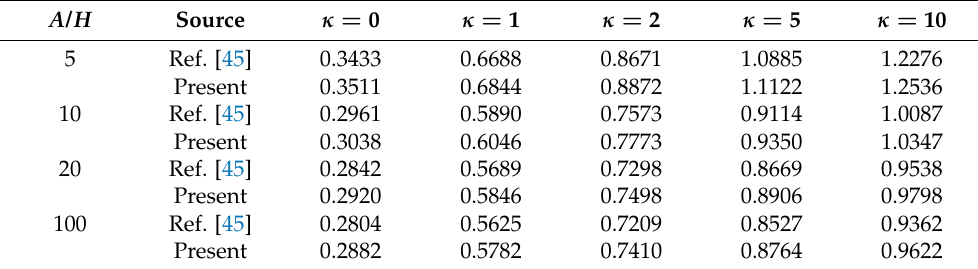
Table 3. Comparison of the central deflection ¯ W of an FGM square